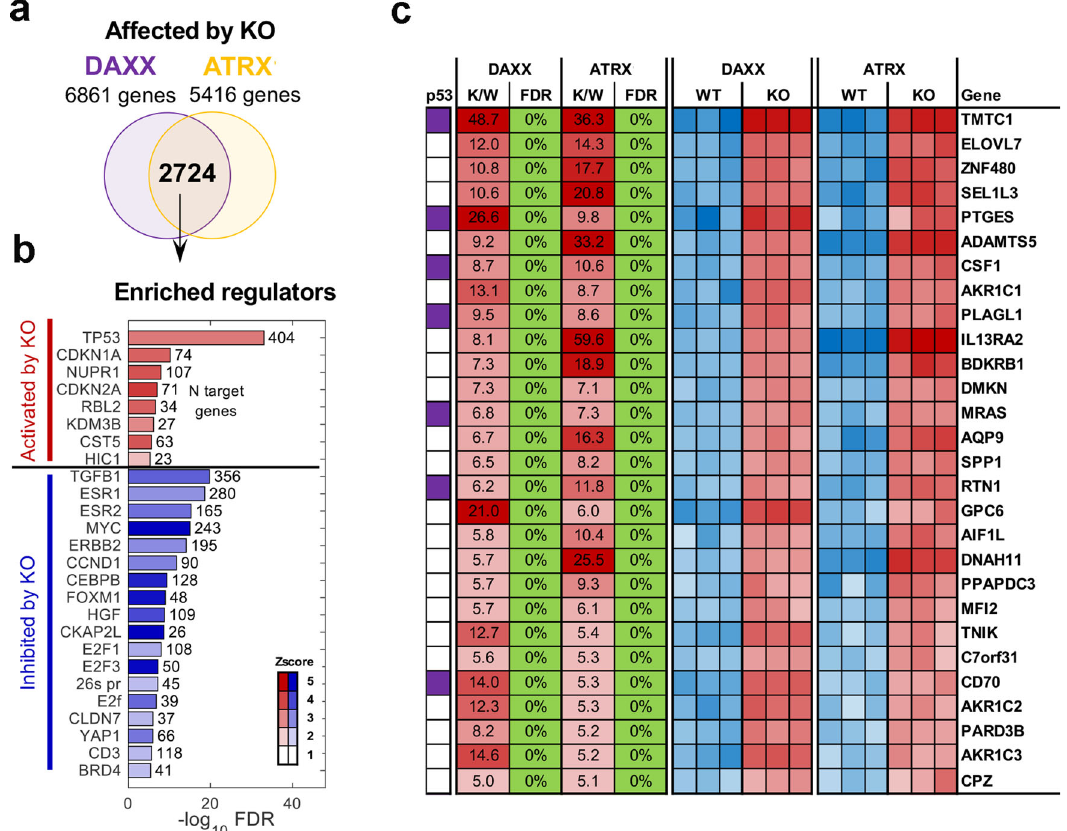
Fig. 1 | Transcriptomic pro fi le of DAXX_KO and ATRX_KO U87 cells. a Venn diagram showing overlap of gene transcripts affected by DAXX_KO or ATRX_KO relative to control U87-T cells based on RNA-seq (Quantseq). b Signi fi cantly enri- ched regulators (FDR<10 − 5 , |Z|>2) predicted by IPA to be activated (red) or